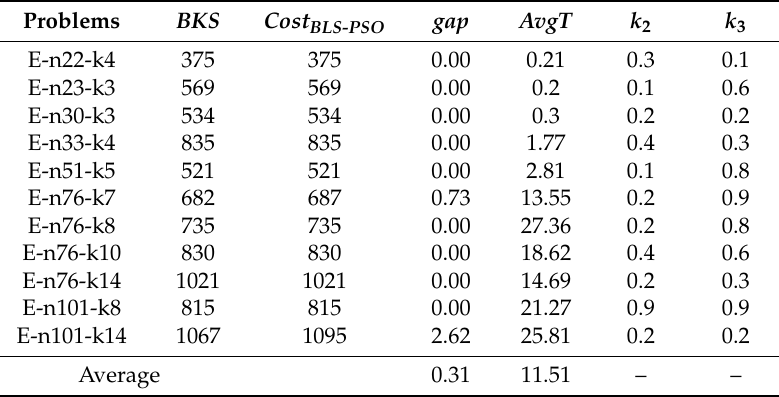
Table 6. Performance of BLS-PSO in solving the benchmark problems in Set E.